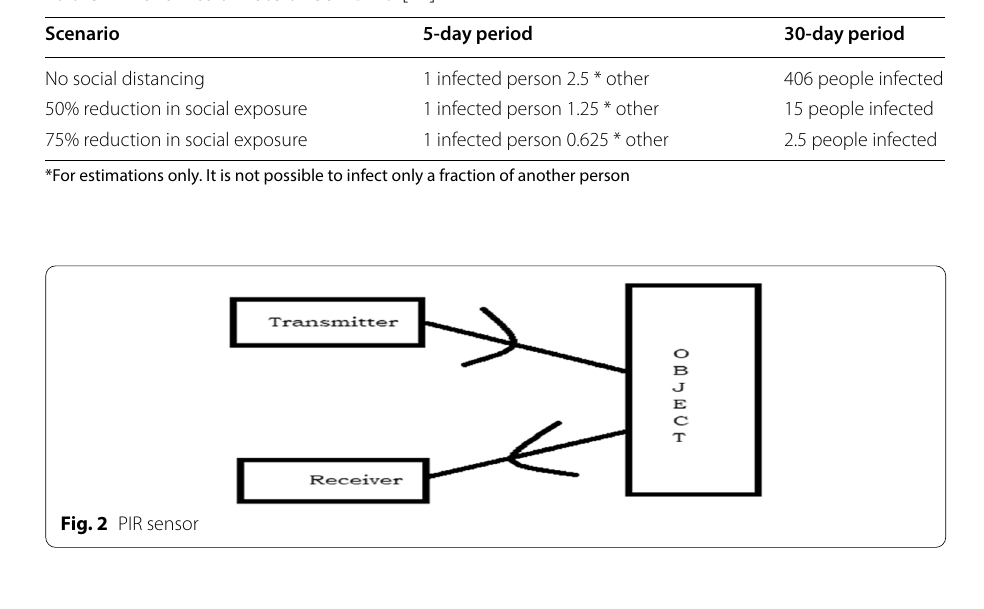
Table 1 Transmission rate of COVID-19 [17]